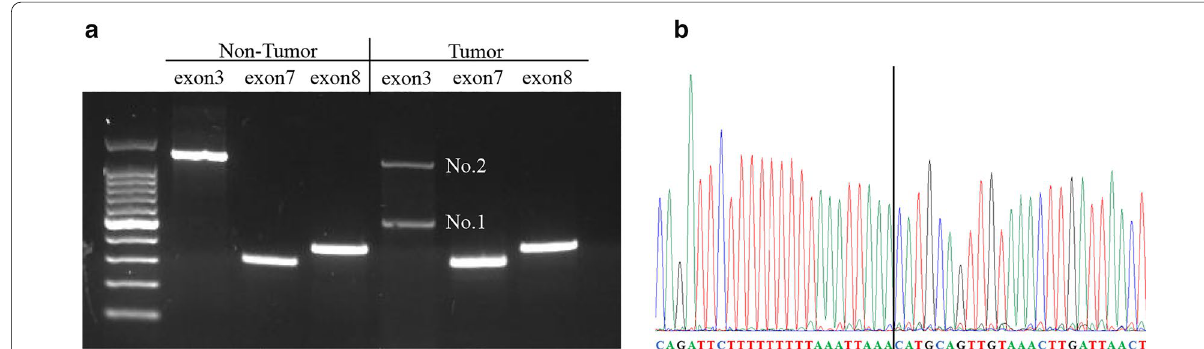
Fig. 5 PCR and direct DNA sequencing results. a Electrophoresis of PCR products for exon 3, exon 7, and exon 8 of the β-catenin gene in tumor and non-tumor tissues. Leftmost is a 100-bp DNA ladder (Takara Bio Inc., Shiga, Japan). The PCR products of exon 3 of the β-catenin gene amplified from tumor DNA show two different bands, while that from non-tumor DNA shows a single band. The same band length is detected in exon 7 and exon 8. b DNA sequencing of exons 3 shows a large deletion, including introns between exon 2 and exon 3 to exon 4. The deletion site is marked by the solid black vertical line. PCR, polymerase chain reaction; DNA, deoxyribonucleic